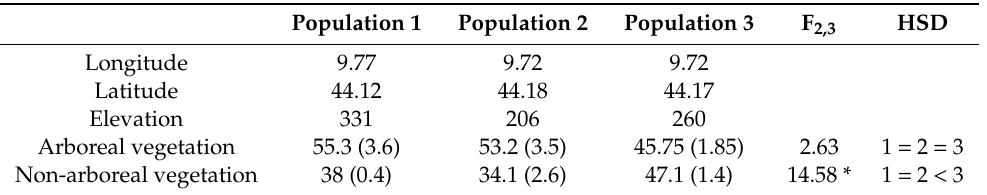
Table 1. Location of the three Hydromantes ambrosii populations analysed in the study. Latitudes and longitudes are reported with a downgraded precision to increase species protection [46]. Information on elevation (m a.s.l.) are included, together with estimations of arboreal and non-arboreal vegetation cover (expressed in %) of the cave’s surrounding areas. Vegetation variables were extracted from Terra MODIS VCF tiles (see text for further details) and, in the table, are averaged over the years 2016 and 2017 (SE in brackets). F values refer to the results of one-way ANOVAs testing for di ff erences among the three locations, considering the years 2016 and 2017 as replicates. * = p < 0.05. The results of post-hoc Tukey HSD tests are also